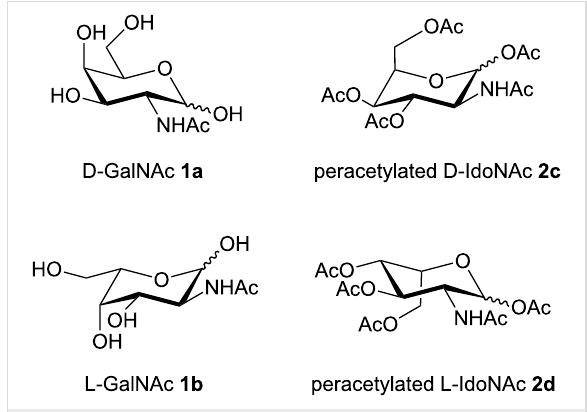
Figure 1: Four possible isomers reachable through the presented ap- proach.